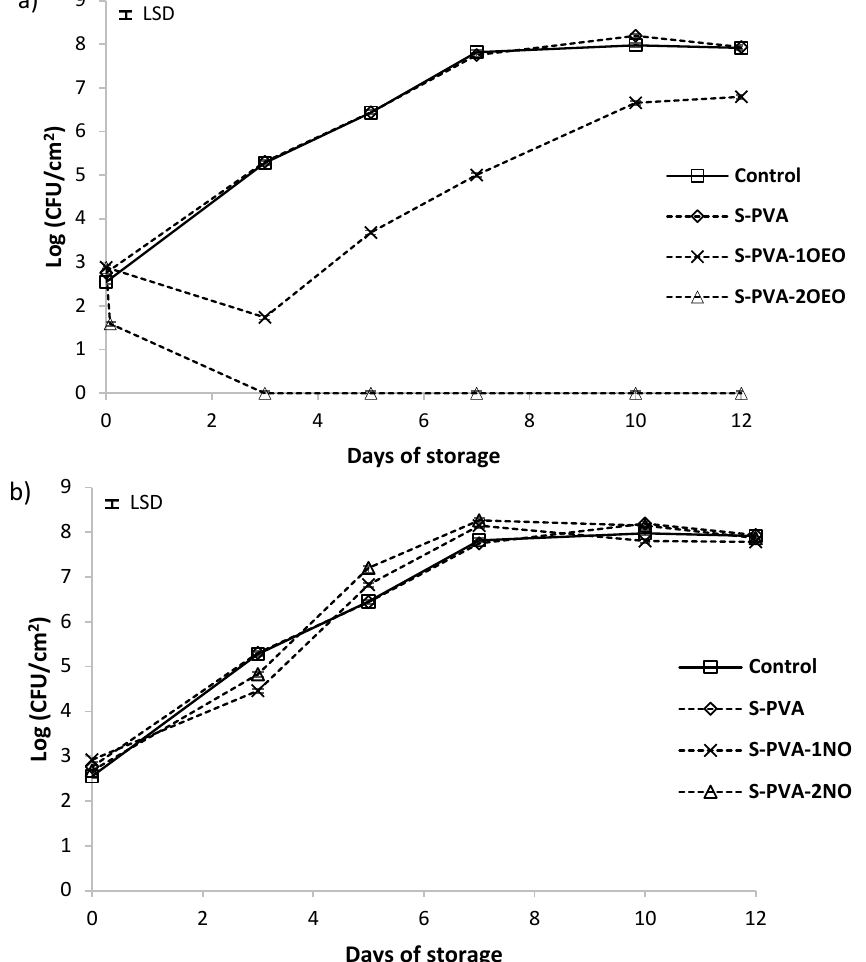
Figure 3. Population viability of Listeria innocua in TSA-NaCl medium at 10 °C ( a ) films with and without oregano essential oil (OEO) and ( b ) films with and without neem oil (NO). Mean values for each incubation period and 95% LSD interval are included in the plot. (LSD = ±0.05).